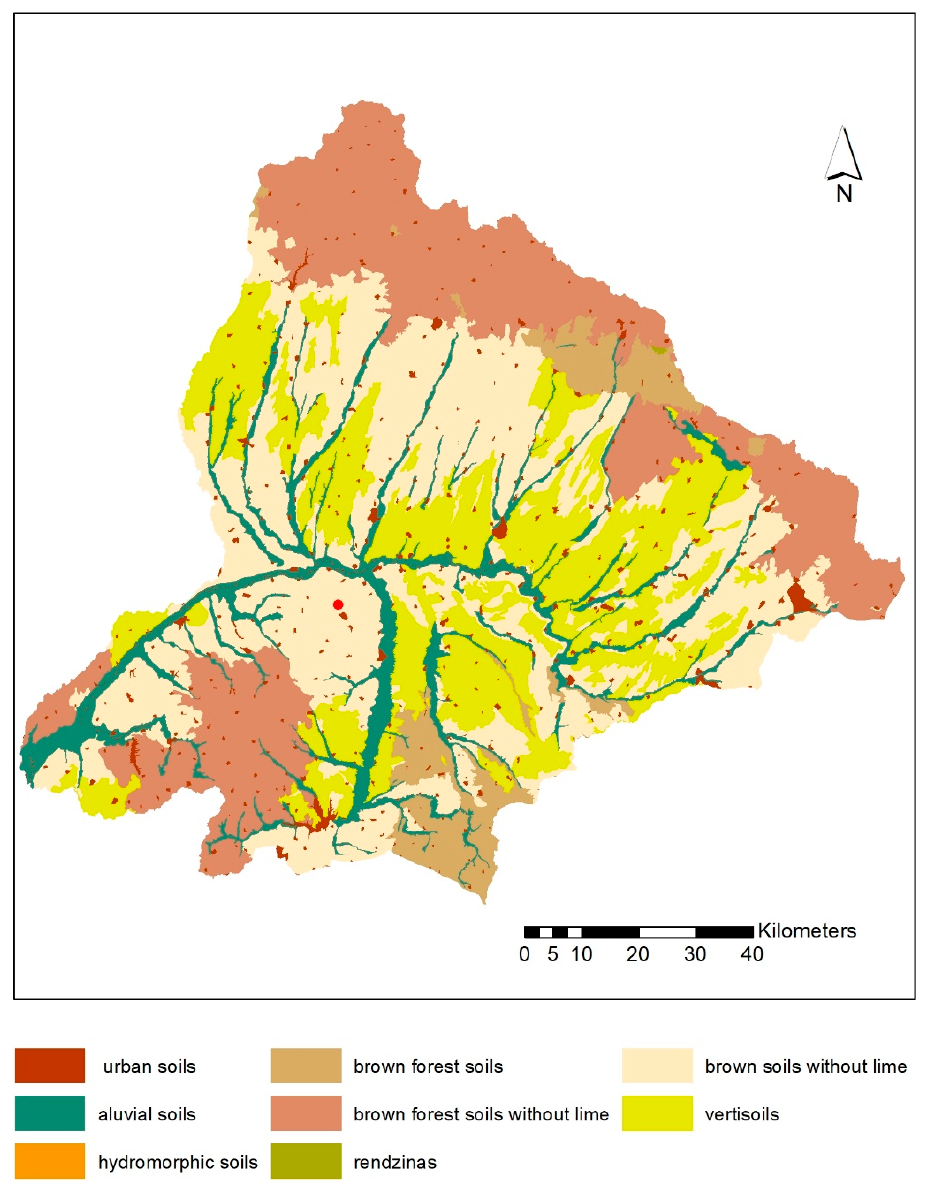
Figure 5. Soil groups in the Ergene River catchment.